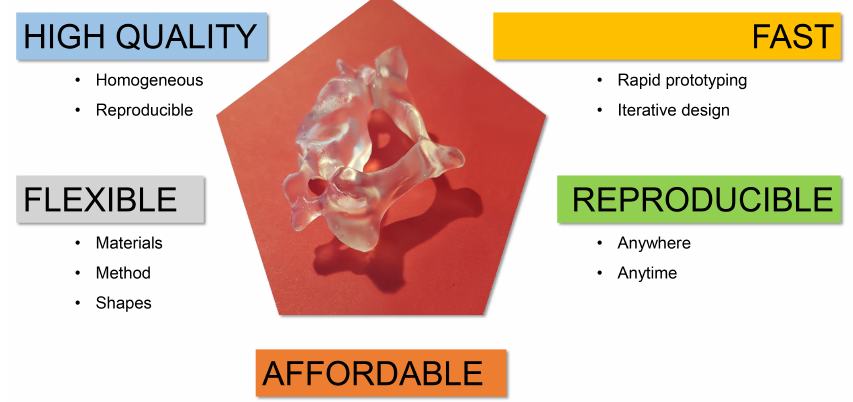
Figure 1. Summary of some properties that make 3D printing suitable for anthropomorphic phantom production. In the centre is a 3D-printed model of a cervical vertebra (C3). You can appreciate the level of detail in the processus spinosus, the processus transversus and the foramen transversarium, for